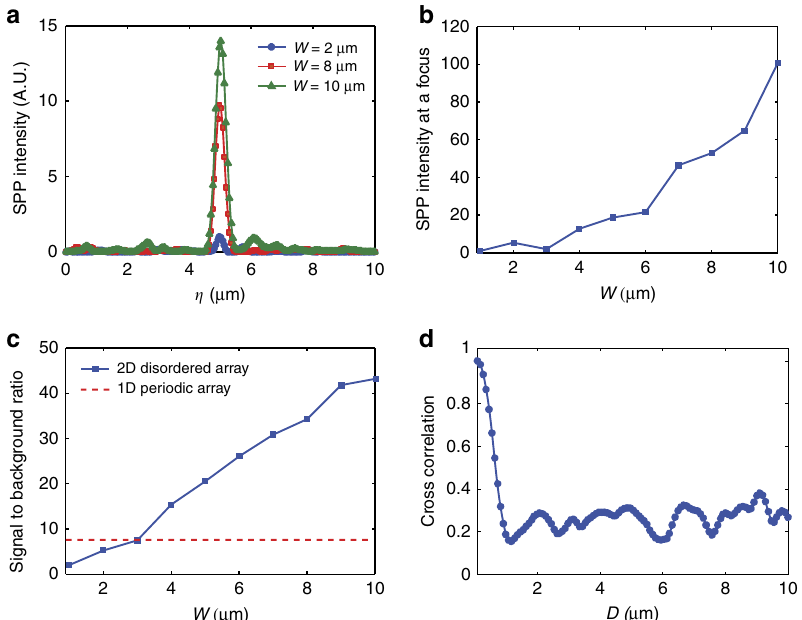
Figure 4 | Demonstration of the increased channel number. ( a ) Line profiles of the SPP intensity along the sampling line for different widths of illumination. ( b ) The intensity of SPPs measured at the target point as a function of the width of illumination. The intensity was normalized at W ¼ 1 m m. ( c ) Effective channel number N 2D determined by the ratio of intensity between the target point and the background with respect to the width of illumination eff (square dots). The red dashed line indicates the signal-to-noise ratio for 1D periodic nanoholes. ( d ) Normalized cross-correlation of the SPPs originating from the segment of nanoholes at 0 (cid:5) y (cid:5) 100nm with those from D (cid:5) y (cid:5) D þ 100nm calculated from the measured transfer matrix (see Supplementary Note 2 for the detailed procedure).